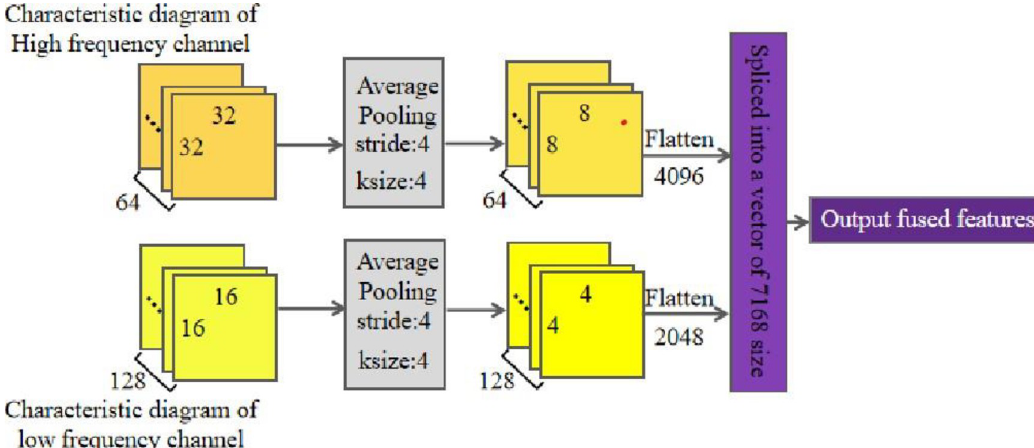
Fig 6. Multi-channel feature fusion process